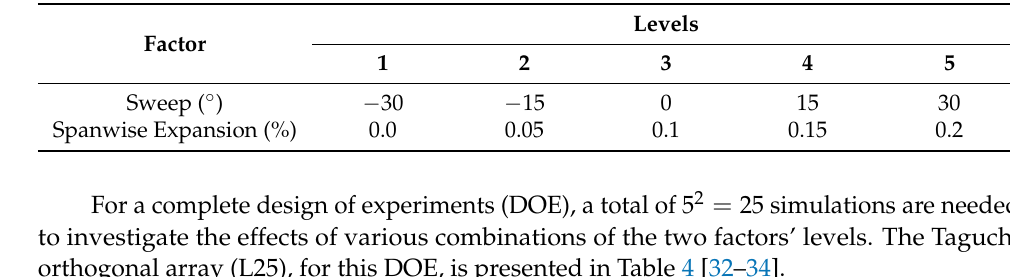
Table 3. Governing factors and their levels.